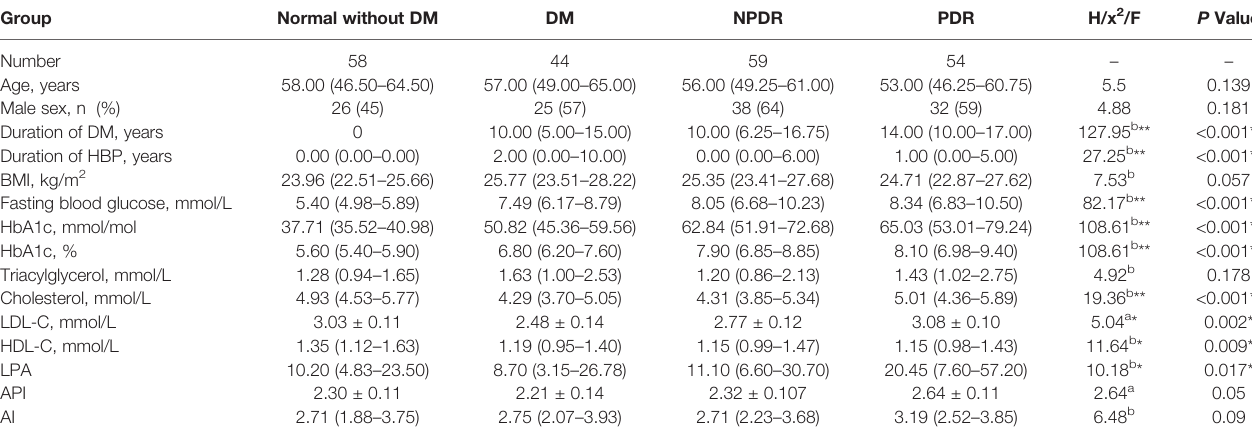
TABLE 1 | Demographic characteristics of the enrolled subjects and the biochemical parameters including lipid pro fi les and arteriosclerosis-associated plasma indices in subjects with normal, DM, NPDP, and PDR. Group Normal without